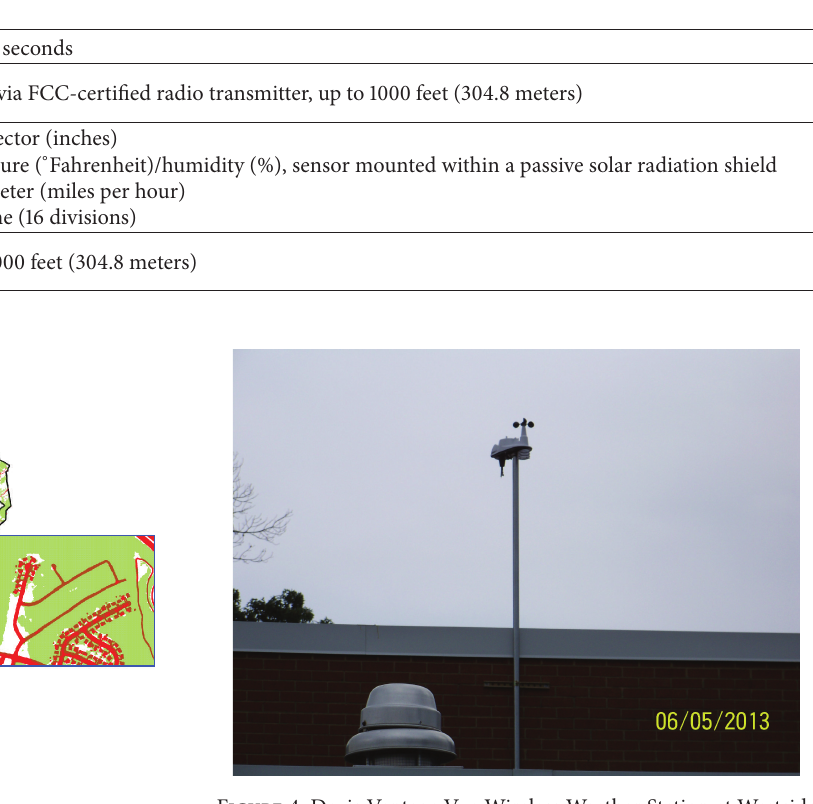
Figure 4: Davis Vantage Vue Wireless Weather Station at Westside Elementary School (photo, first author,